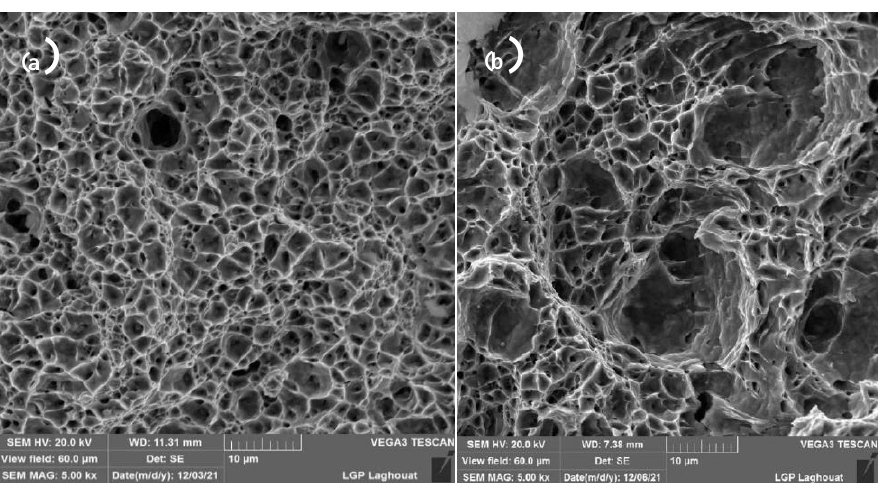
Fig. 5. SEM micrographs of fracture surface for different tempering temperatures: a) 300 °C, and b) 400